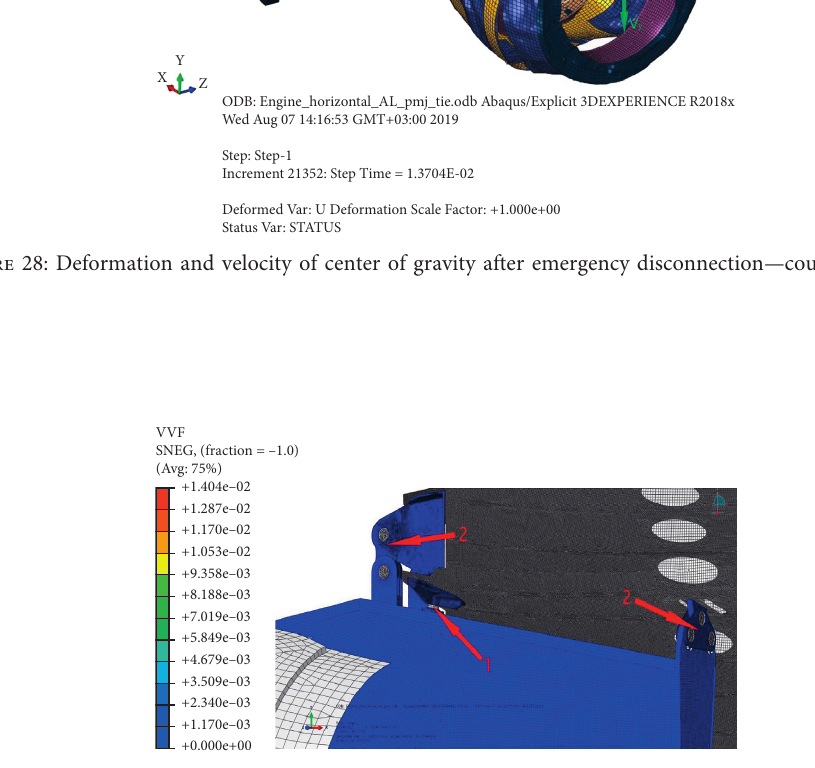
Figure 29: Emergency disconnection sequence of wheel retraction—course of